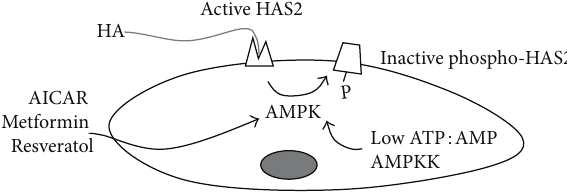
Figure 2: Schematic representation of the regulation of HA syn- thesis by AMPK in SMCs. Through the action of compounds such as AICAR, metformin, and resveratrol or by sensing ATP :AMP ratio or by the action of AMPK upstream kinases (AMPKK), AMPK phosphorylatesHAS2threonine110residueinhibitingHAS2activity and reducing the HA